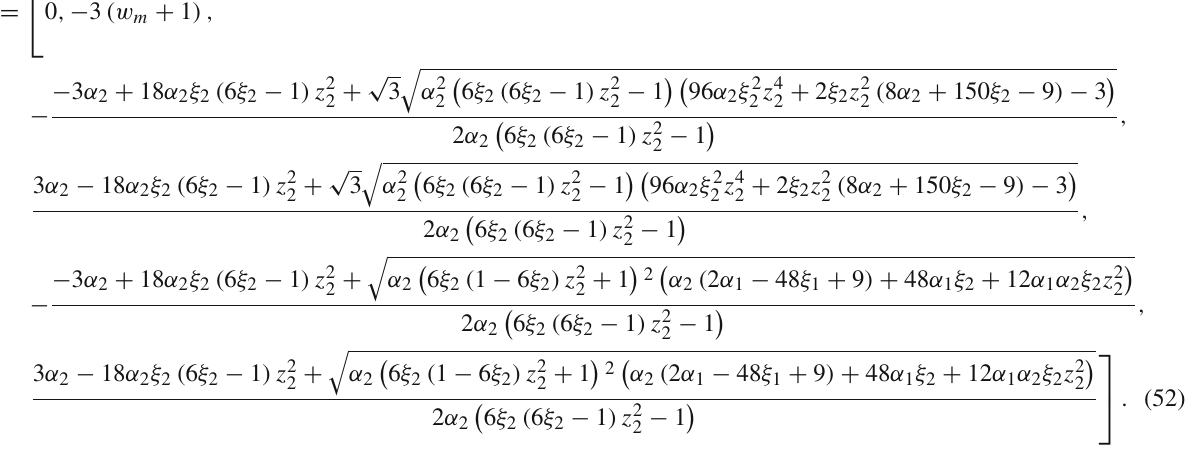
Fig. 9 The evolution towards P 8 critical point in the { z 1 , z 2 } variables for the same values of the parameters as in Fig. 8 ⎡ = E P 9